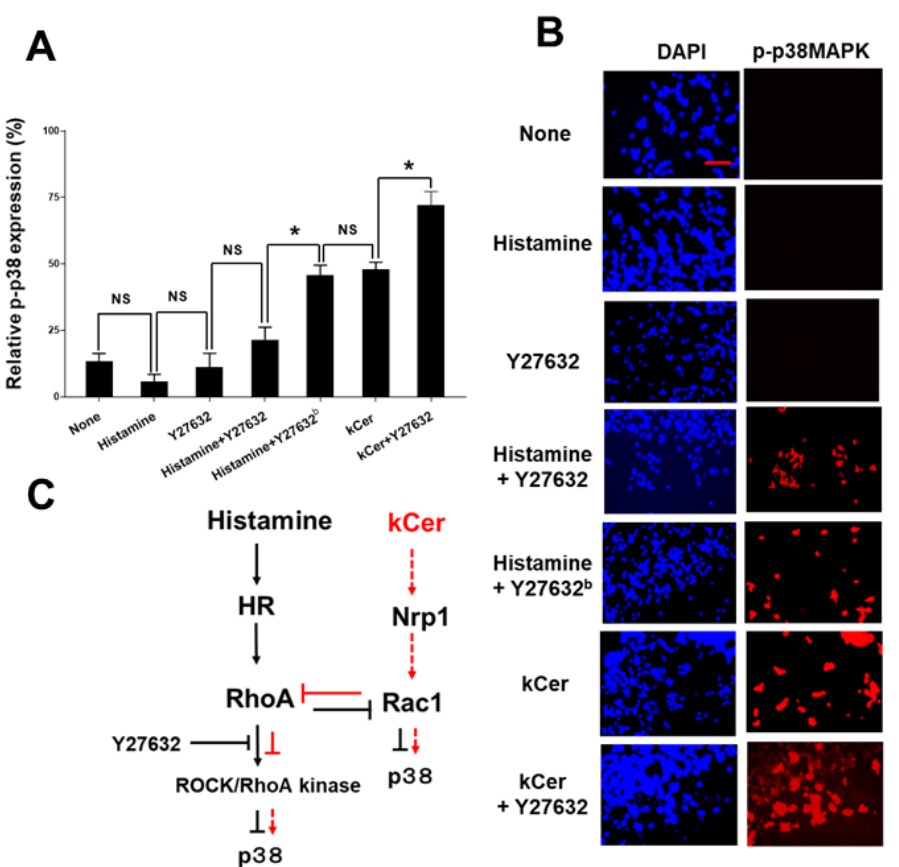
Figure 5. Downstream pathway crosstalk between histamine-related (HR) signaling and kCer-related Nrp1 signaling. ( A ) Effects of Y27632 on p38MAPK activation induced by treatment with histamine and kCer. HaCaT cells were undifferentiated by long-term cell culture in L-Ca medium. Cells were then treated with histamine (10 µ M), Y27632 (0.1 µ M), Y27632 b (1.0 µ M), or kCer (10 µ M). The cells were subjected to a p-p38MAPK cell-based translocation assay kit. The results are presented as the means and standard deviations of three individual experiments. Statistical significance (* p < 0.01 vs. the represented treatment), not significant (NS), respectively, one-way ANOVA followed by Tukey’s multiple comparison post-test. ( B ) Representative images of pp38MAPK activation in experiments using Y27632, kCer, and histamine. Scale bar = 100 µ m. ( C ) Proposed model for downstream pathway crosstalk of histamine and